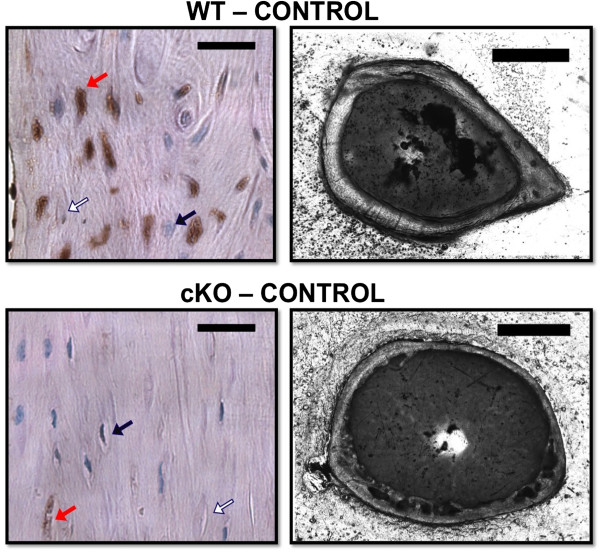
Cx43 expressing osteocytes. Left: Representative images demonstrate the relative absence of Cx43+ osteocytes in the femur midshaft cortical bone of cKO mice compared to WT. Red arrow: Cx43+ osteocyte, blue arrow: Cx43- osteocyte, white arrow: empty lacunae. The black bar represents 25 μm. Right: Cross-sections of the femur midshaft taken via light microscope reveal the osteopenic cortical phenotype of cKO mice. The black bar represents 1000 μm.